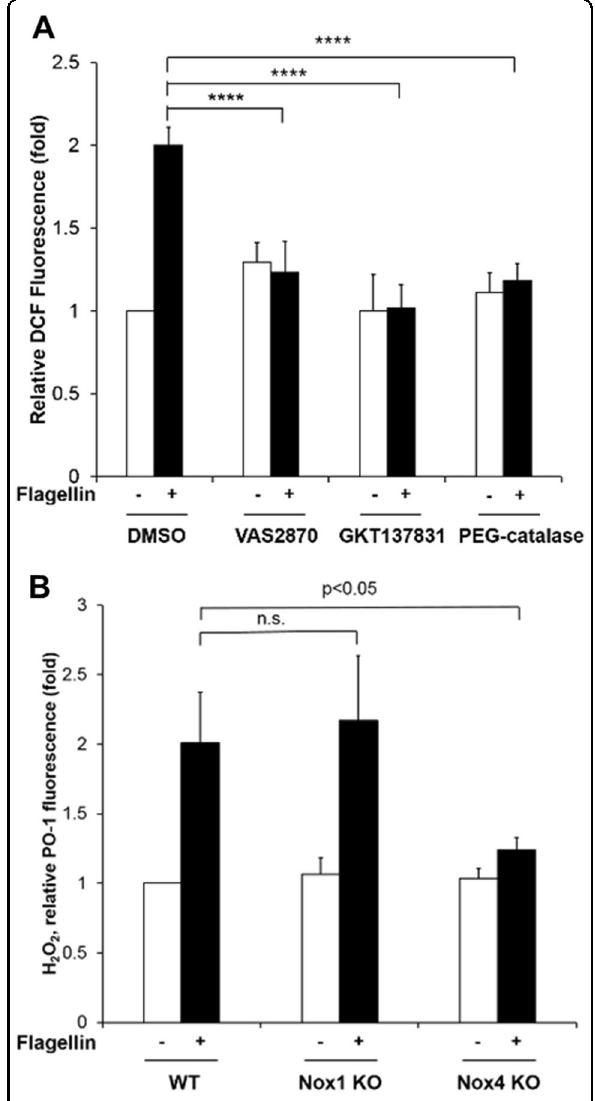
Fig. 1 Nox4 is required for fl agellin-induced H 2 O 2 generation in smooth muscle cells. a WT SMCs were pretreated with VAS2870 (10 μ M), GKT137831 (10 μ M), or PEG-catalase (50 U/mL) for 30 min, stimulated with fl agellin (100 ng/mL) for 10 min, and then incubated with DCF-DA for 10 min. The generation of ROS was monitored by confocal microscopic analysis of DCF fl uorescence ( N = 3, mean ± SD, **** p < 0.0005). b WT, Nox1 KO, and Nox4 KO mouse SMCs were serum-starved for 16 h and incubated for 15 min in the dark at 37 °C with 5 μ M PO-1. Then, fl agellin (100 ng/mL) was added to the dye/cell mixture. The generation of H 2 O 2 was monitored by confocal microscopic analysis of PO-1 fl uorescence ( N = 3, mean ± SD, n.s. represents nonsigni fi cance, * p <